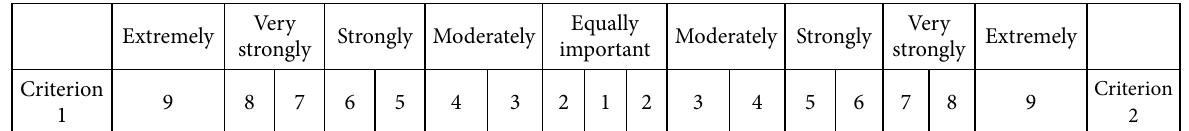
Table 4. Scale of importance for pairwise